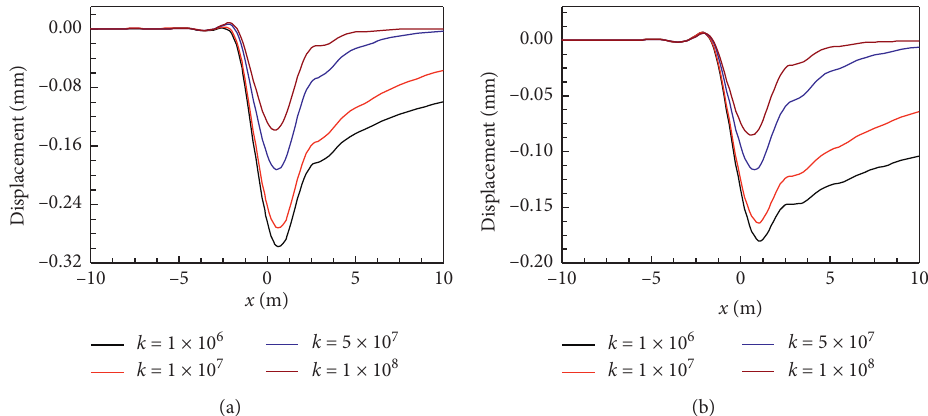
Figure 7: The effect of linear stiffness on the history of vertical displacement at the middle of the track corresponding with location of the moving vehicle: (a) v � 50 m/s and (b) v � 75m/s.